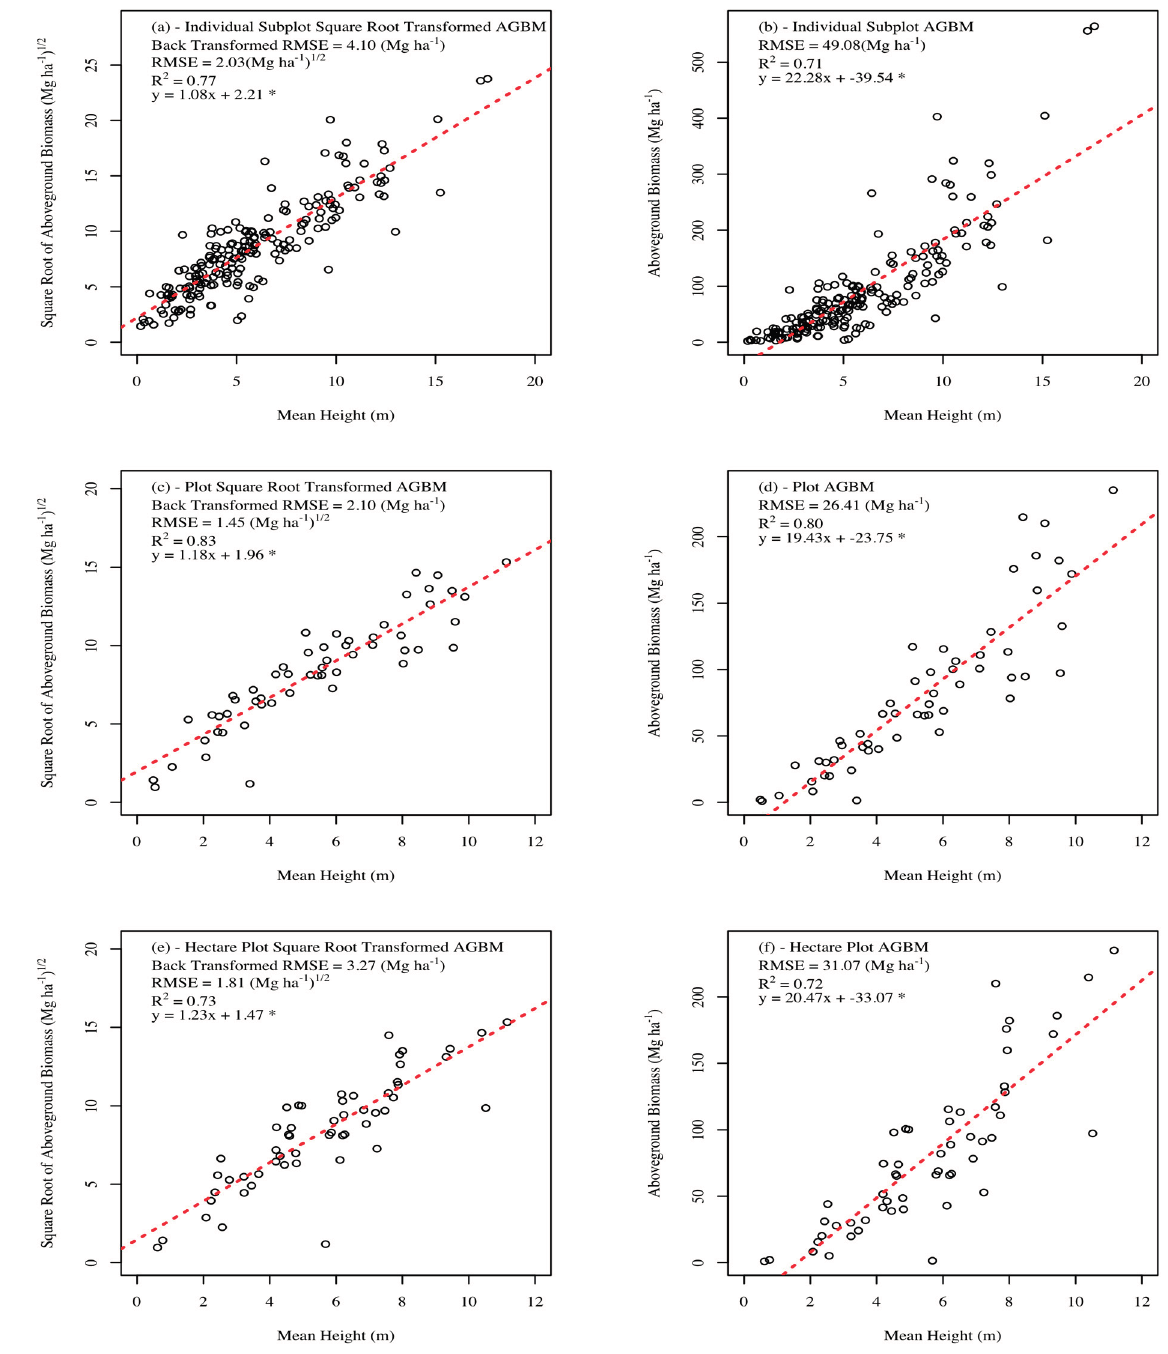
Figure 7. Scatter plot of simple linear regression results for the best simple linear regression aboveground biomass models (transformed and non-transformed) for individual subplots ( a , b ), plots ( c , d ), and hectare plots ( e , f ). * indicates p -values of less than